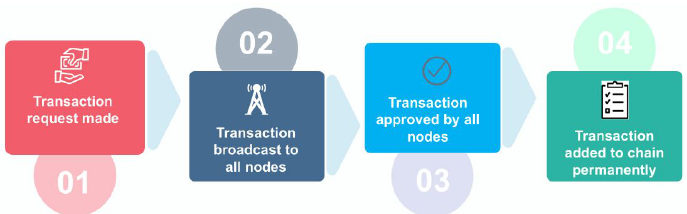
Figure 4. A workflow of the blockchain process.